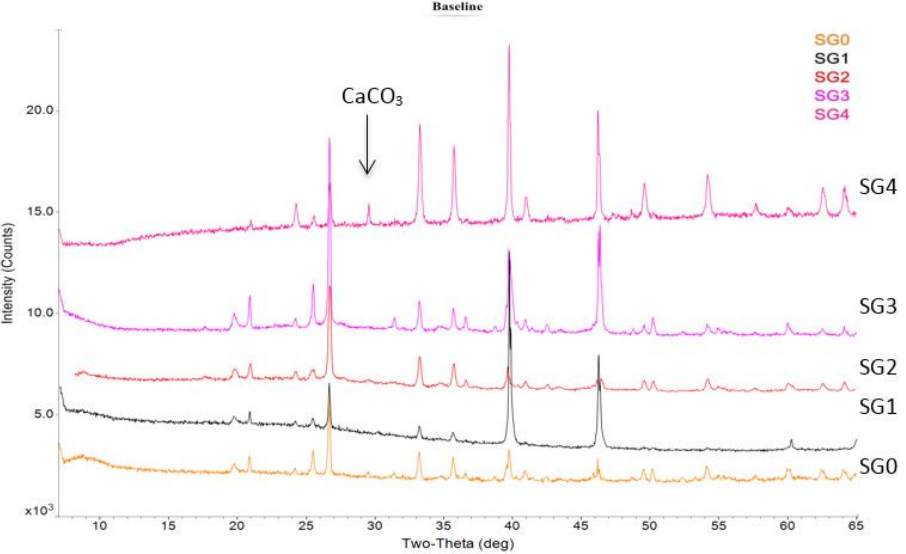
Figure 5. Presence of significant amount of CaCO 3 seen only in SG4 fraction using X-ray diffraction (XRD) on ash samples prepared at 650 °C.